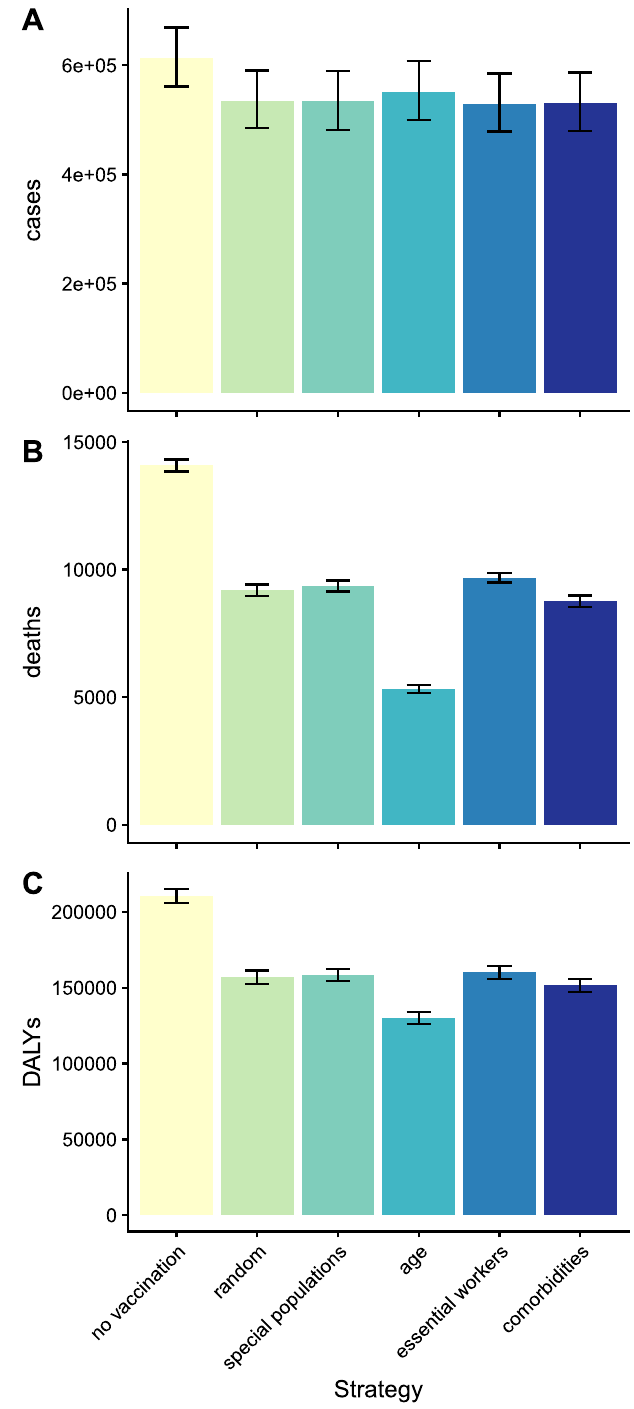
Figure 3. Simulated impact of different COVID-19 vaccine prioritization strategies in California on numbers of COVID-19 clinical cases, deaths and DALYs for 5 million people vaccinated. Simulated ( A ) clinical cases, ( B ) deaths and ( C ) DALYs in California in the first 6 months of 2021. Five different prioritization strategies were considered: (i) random allocation, (ii) targeting special populations (prisoners, education workers, people experiencing homelessness), (iii) age targeting, (iv) targeting essential workers, (v) targeting individuals with comorbidities. All strategies assumed that all healthcare workers and long-term care facility residents were vaccinated first as per the US CDC recommendation 11 . Vaccine efficacies against clinical disease and death were assumed to be initially 90% and 95% and to wane gradually over time (see Supplementary Information). Bars show mean estimates across 1000 simulations, error bars show 95% uncertainty intervals from stochastic uncertainty and parameter uncertainty. Results for 2 million and 10 million individuals vaccinated are shown in Figure